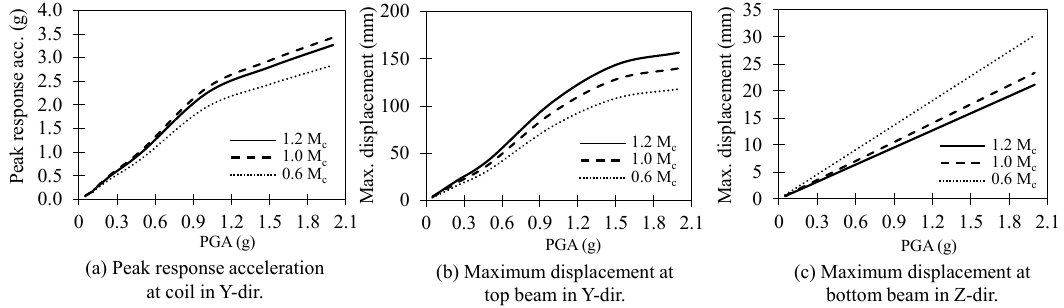
Figure 19. Effect of coil mass variation on dynamic responses according to PGA.